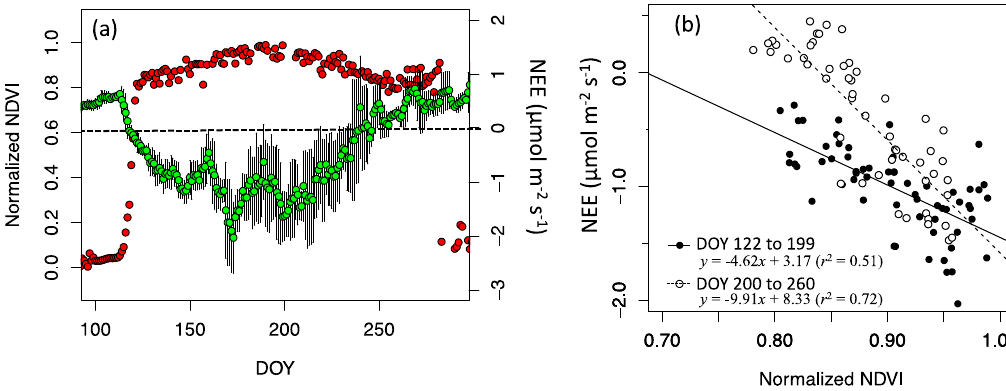
Figure 6. ( a ) Seasonal changes in daily NEE (green circles) and mean normalized NDVI (red circles) between 10 am to 11 am. The five days moving window average was applied to the daily NEE data. Errorbars indicate the standard deviation of the moving window average. ( b ) Linear regressions between normalized NDVI sat and NEE in the spring-to-summer period (DOY 122 to 199) and the summer-to-autumn period (DOY 200 to 260).